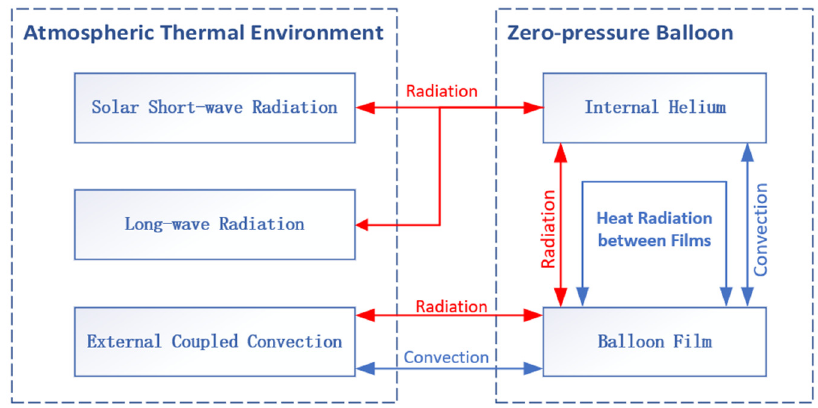
Figure 3. Heat transfer mechanism of the thermal model.